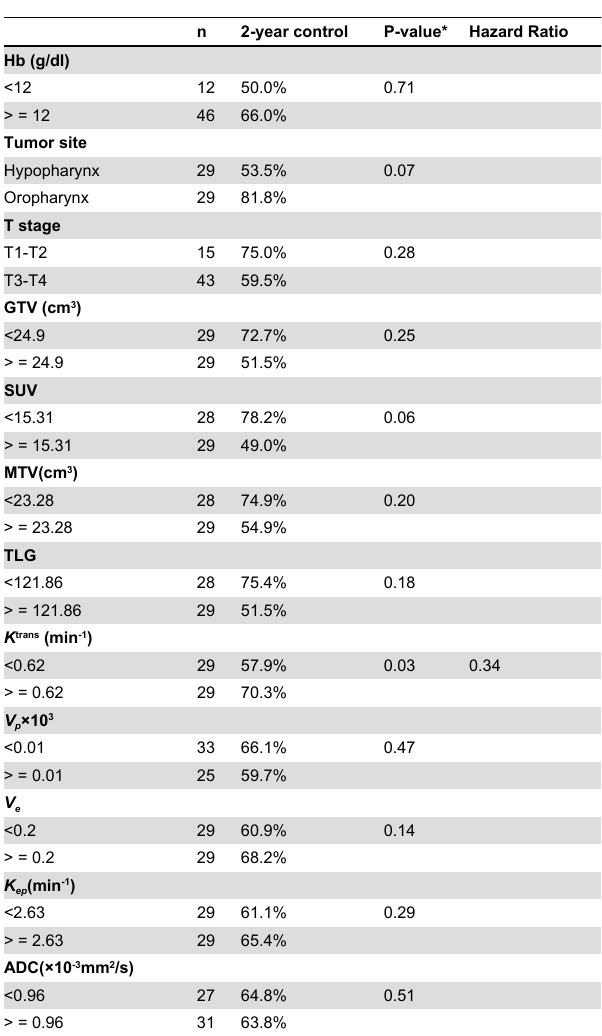
Table 2. Relationship between local failure and the